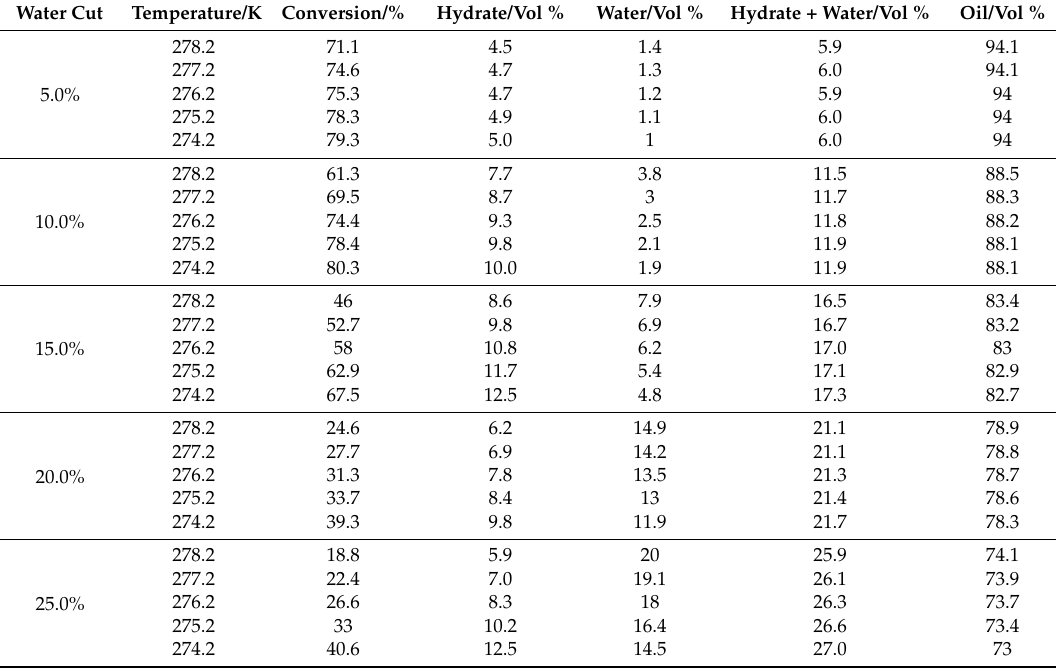
Table 2. Conversion ratios of water and volume fractions of different phases for equilibrium viscosities for annealed hydrate slurries with AA-2 formed at 278.2 K, with initial pressure of 6.0 MPa and stirring speed of 300 rpm and a water cut from 5% to 25% 1